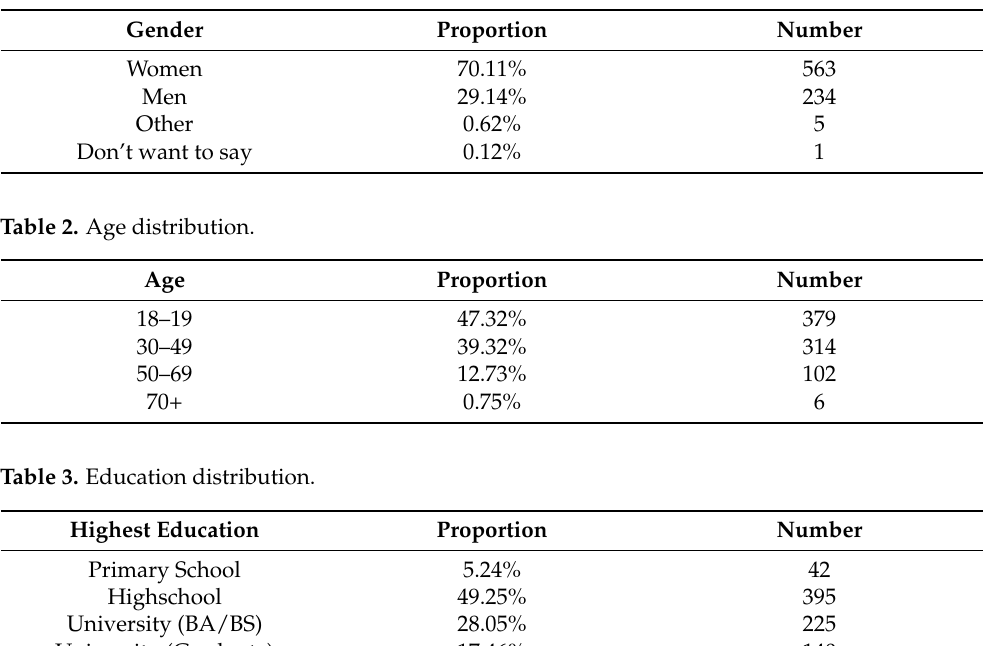
Table 1. Gender distribution.